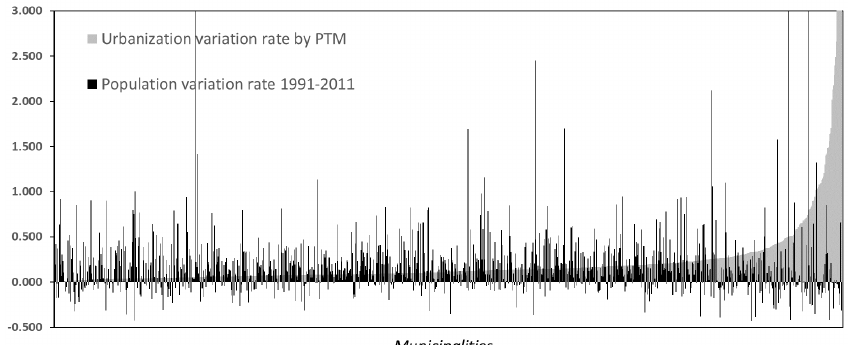
Figure 5. Demographic dynamics for the period 1991–2011 compared to the rate of urban increase per individual municipality according to their planning tools inserted in the Lombardy region PTM. Municipalities with Urban Density (UD) < 25%.